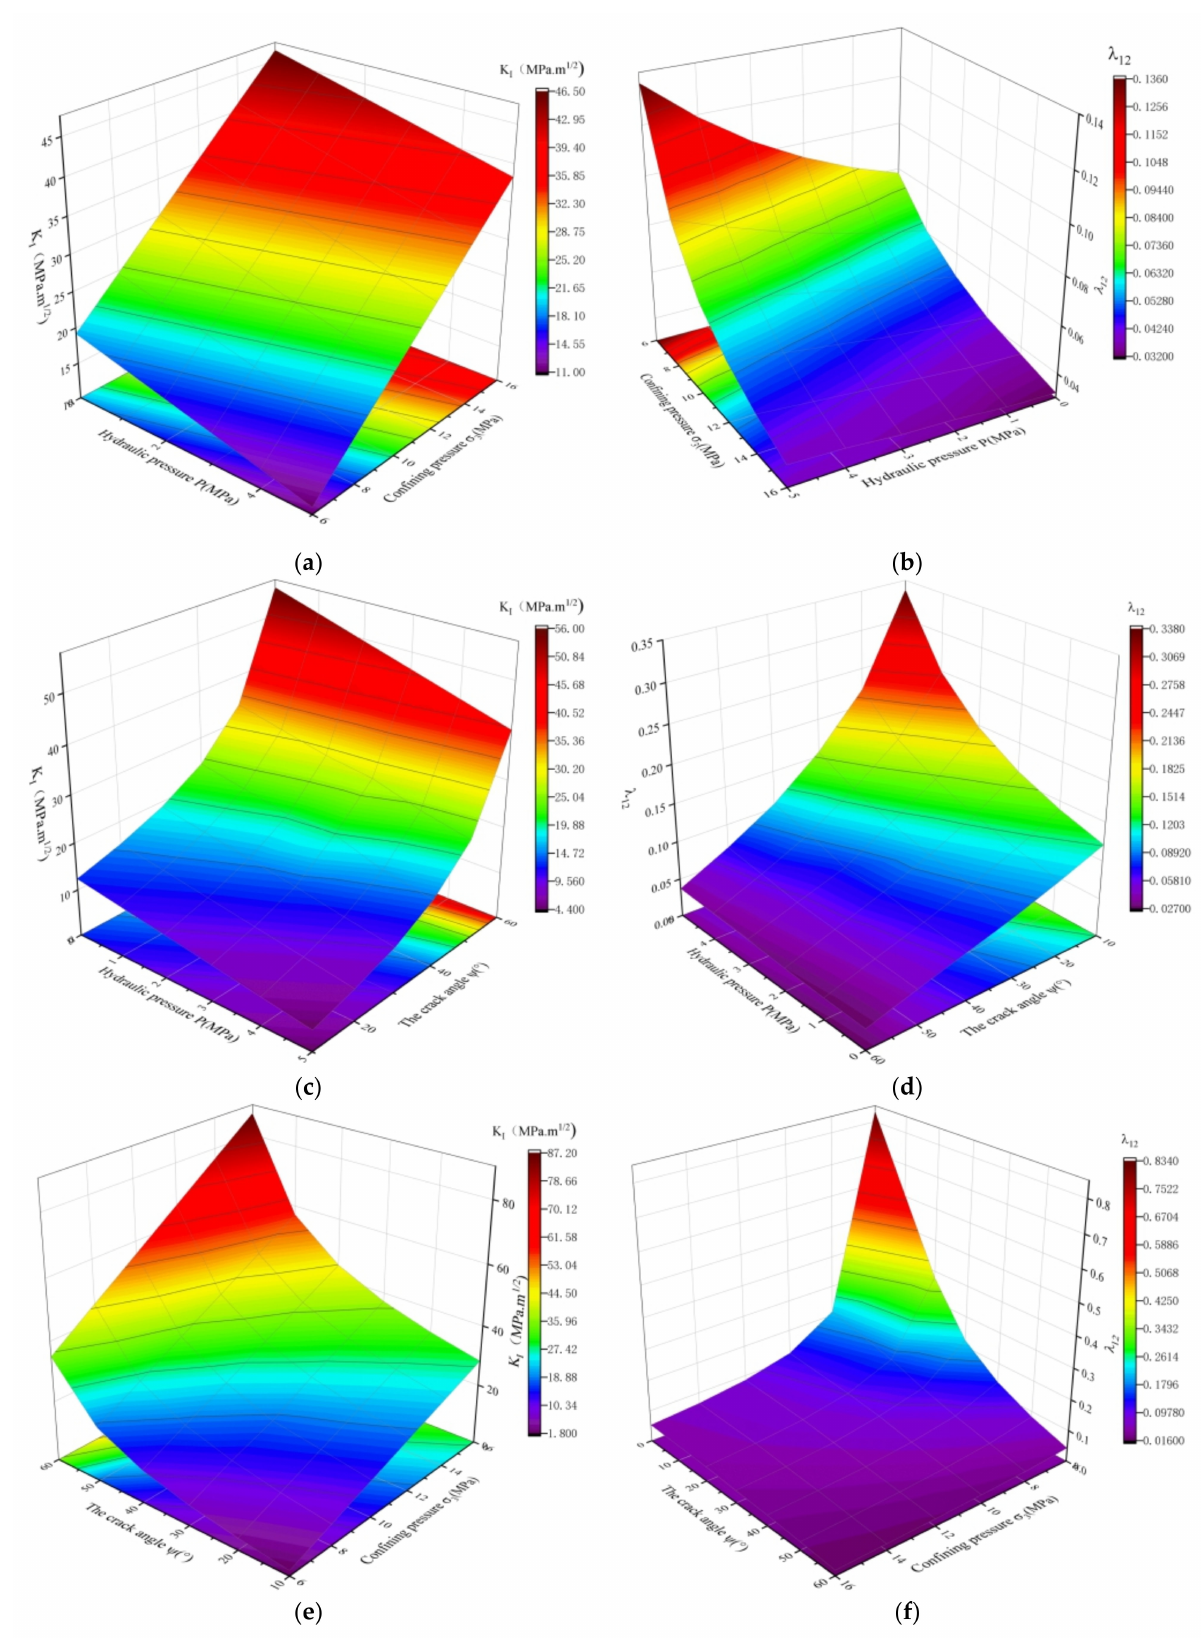
Figure 11. Coupled action surfaces. ( a ) Surfaces of the coupling effect of confining pressure and hydraulic pressure on type I stress intensity factor; ( b ) surfaces of the coupling effect of